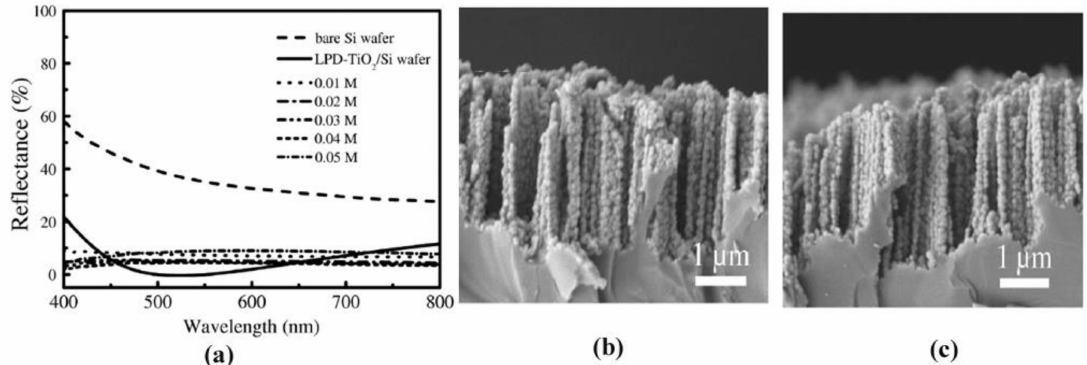
Figure 18. ( a ) The reflectance curve of LPD-TiO 2 thin film on SiNWs with di ff erent H 3 BO 3 concentration in 400 to 800 nm wavelength range. ( b ) SEM cross-sectional images of LPD-TiO 2 (0.3 M) / SiNWs / Si, ( c ) LPD-TiO2 (0.4 M) / SiNWs / Si. Reprinted with permission [152]; 2017,